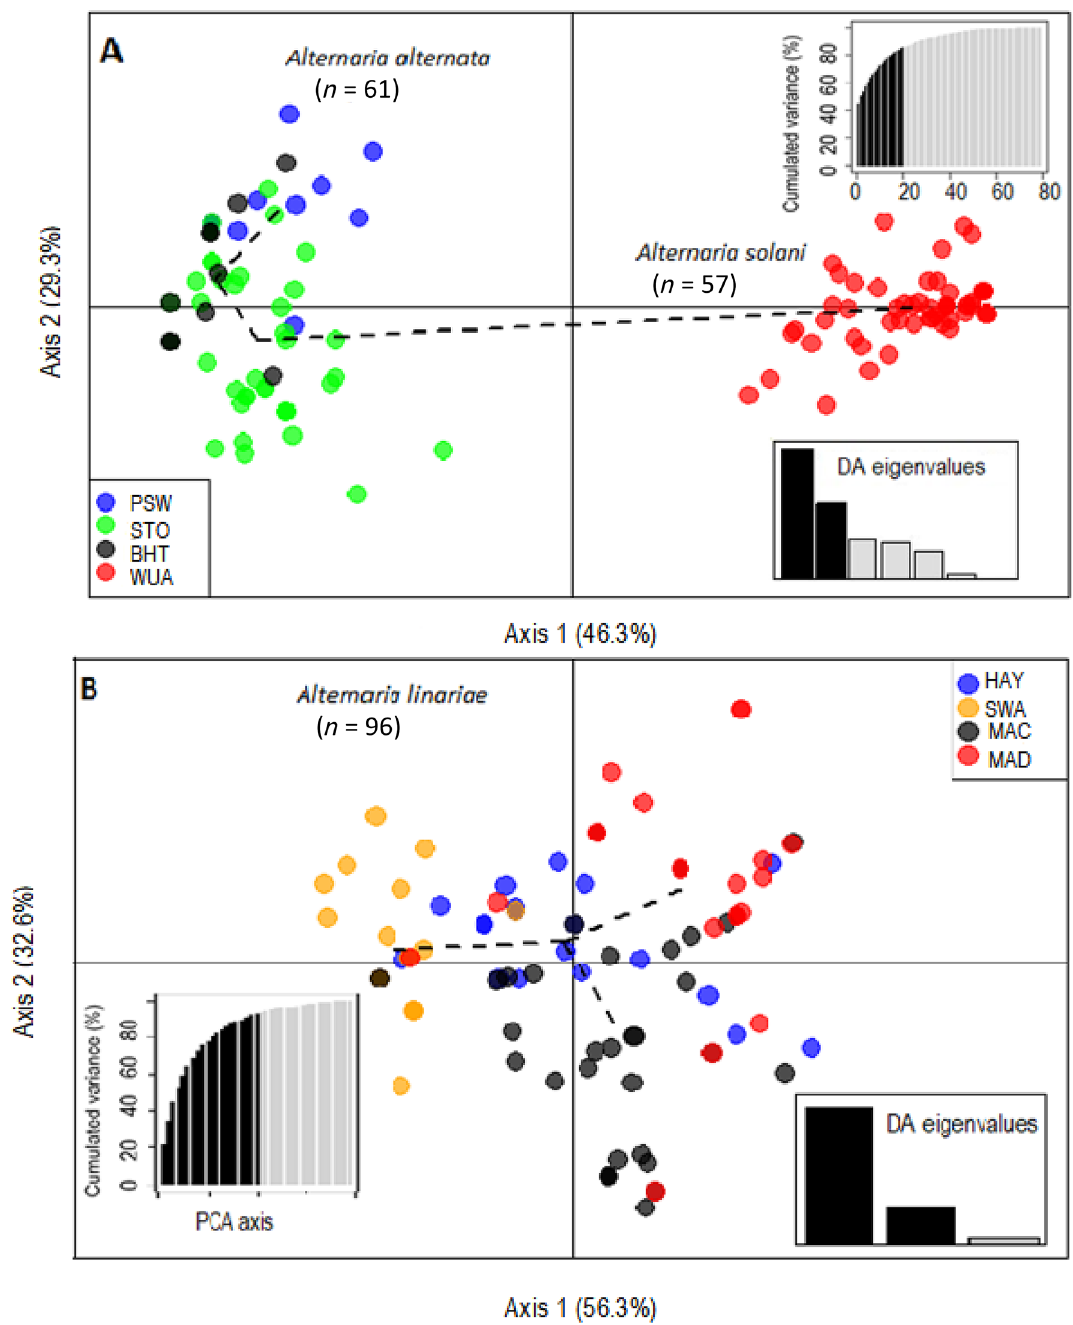
Figure 3. The discriminant analysis of principal components (DAPC) model showing clustering of eight geographic location populations of three Alternaria spp. as defined in the methods using 220 single nucleotide polymorphisms (SNPs) from 10 microsatellite loci. For the A. alternata and A. solani populations ( A ), alleles contributed more than 5% to the first principal component (Axis 1), and alleles contributed more than 5% to the second principal component (Axis 2). For A. linariae populations ( B ), alleles that contributed more than 5% to the first principal component (Axis 1) and alleles that contributed more than 5% to the second principal component (Axis 2). Lines and shapes represent individual genotypes, colour-coded by their original sampling location, and surrounded by ellipses. Discriminant analysis (DA) and principal component analysis (PCA) eigenvalues represent the amount of genetic variation captured by the analysis. PCA eigenvalues are the cumulative variance explained by the retained principal components. DA eigenvalues represent which linear discriminants are compared in each scatter plot, with the height of each bar representing the relative contribution in explaining total